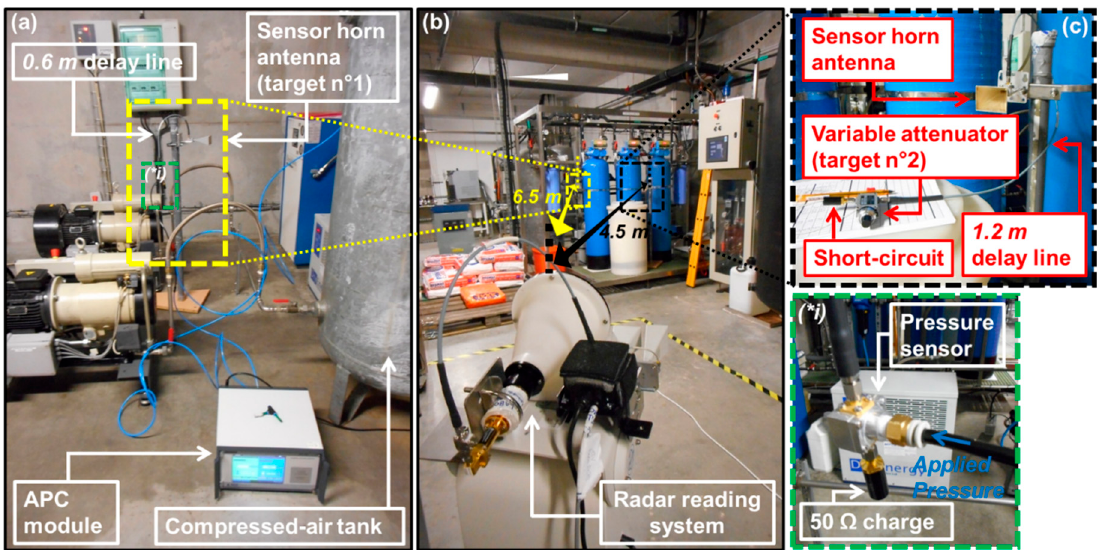
Figure 5. Wireless measurement setup in an electromagnetic reverberant environment. Figure 5b indicates the position of Targets n°1 (pressure sensor) and Target n°2 (antenna loaded by a variable microwave resistor that mimics a pressure variation). Figure 5a and inset ( i ) show the connection setup for Target n°1. Figure 5 c shows the connection setup for Target n°2.